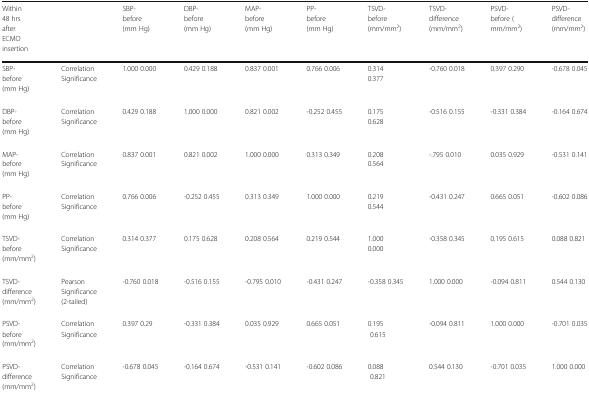
Table 1 (abstract 0093). Correlations between hemodynamic and microcirculation parameters Within 48hrs after ECMO